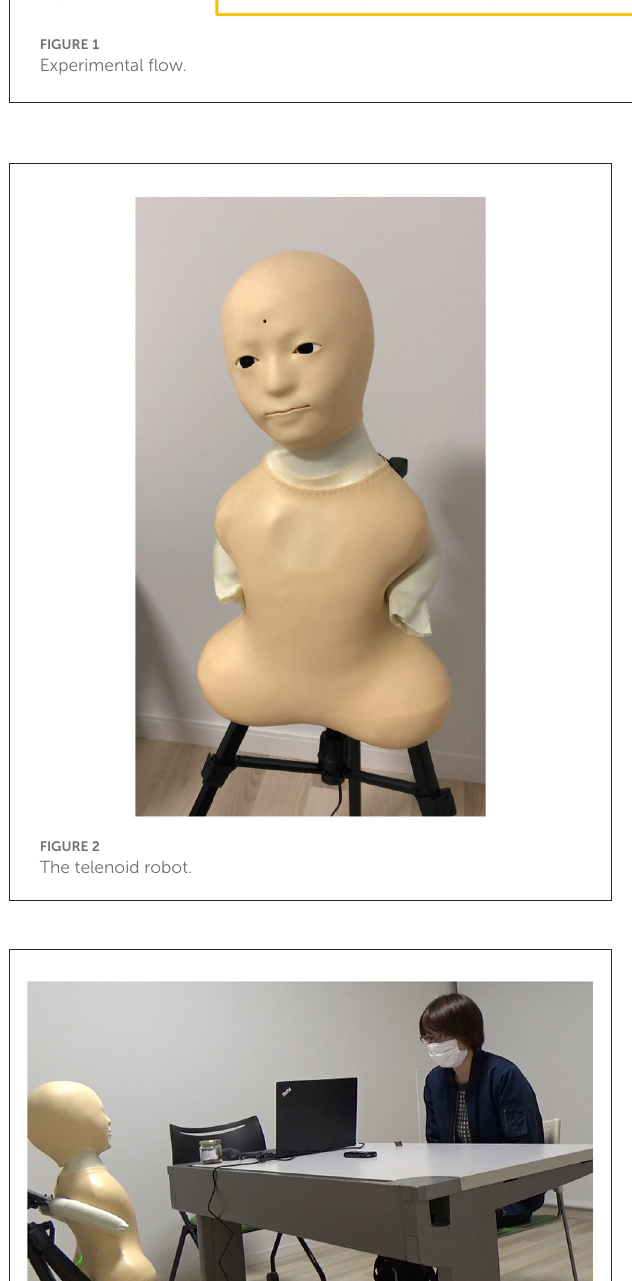
As shown in Figure 3, the participants are seated in a room alone with the Telenoid. The participants sit directly facing